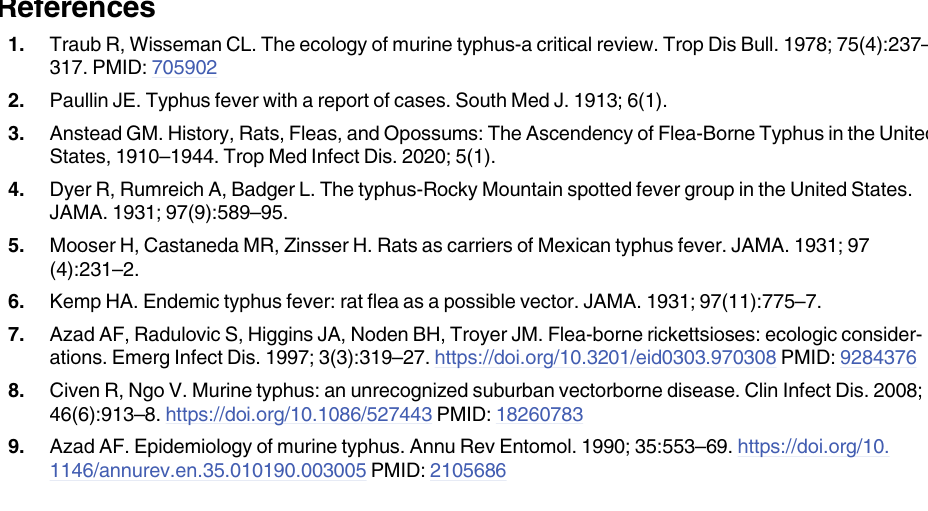
S1 Table. Seropositive rate of anti- R . typhi responses in small mammals and incidence rate (per 100,000 person-years) of indigenous murine typhus for each month from 2007–2019. S2 Table. Seropositive rate of anti- R . typhi responses in different small mammals for each study port from 2007–2019. S3 Table. Incidence rate (per 100,000 person-years) of indigenous murine typhus for each administrative district from